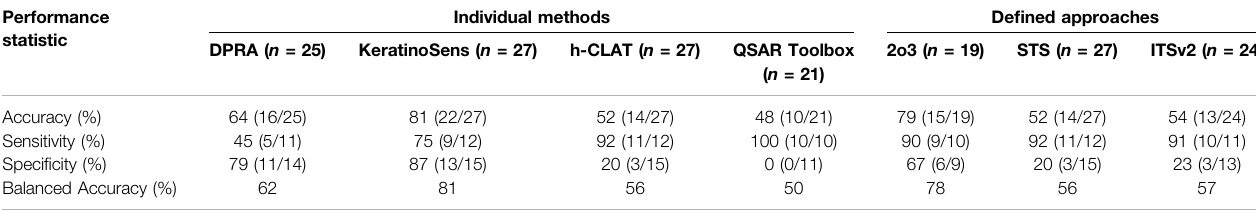
Individual methods De fi ned